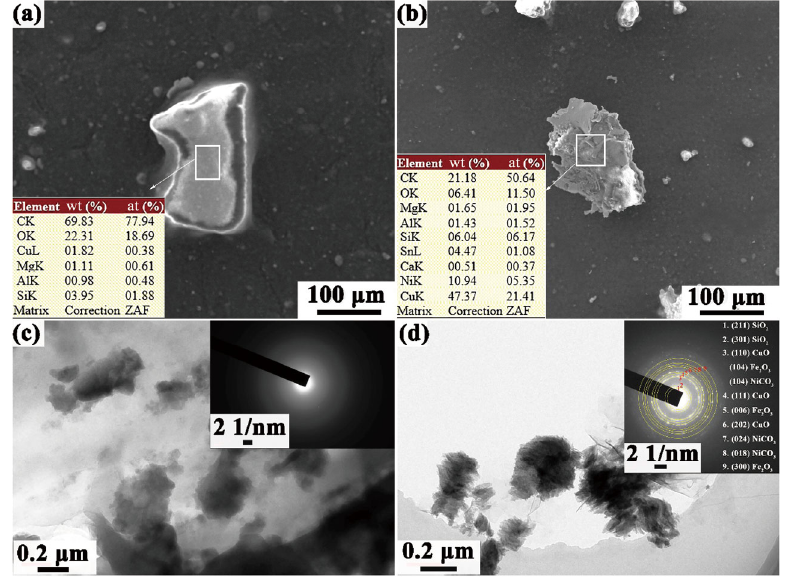
Fig. 14 (a, b) SEM and (c, d) TEM images of wear debris under different normal loads at a sliding speed of 2.58 m/s, with the insets showing EDS and selected area electron diffraction: (a, c) 50 N and (b, d) 700 N.